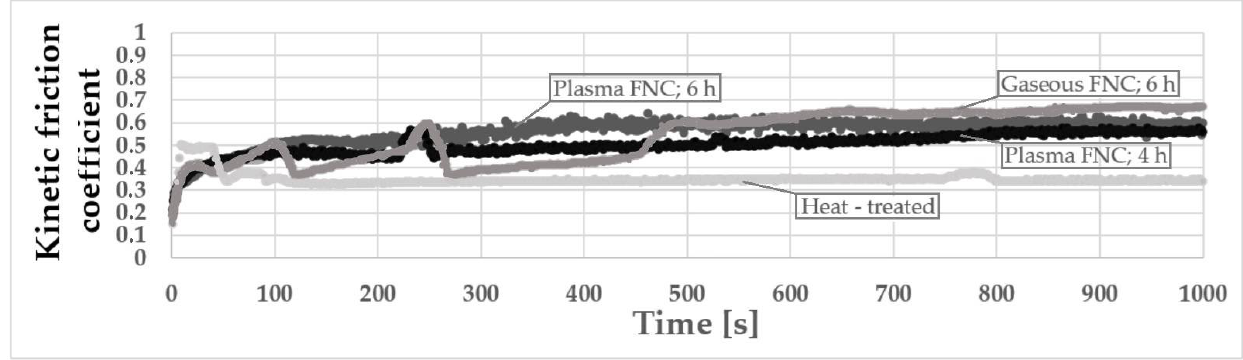
Figure 7. Friction coefficient comparison of heat-treated and ferritic nitrocarburized surfaces. The Figure 7 implies that application of all selected chemical heat treatment processes caused a significant deterioration of surface friction coefficient in comparison with a solely heat-treated surface. To have a better chance of describing the phenomenon, the friction coefficient measurement was accompanied by the measurement of the roughness profile parameters listed in Table 3. Table 3. The values of roughness profile parameters of surfaces subjected to the selected chemical heat treatments. Parameter